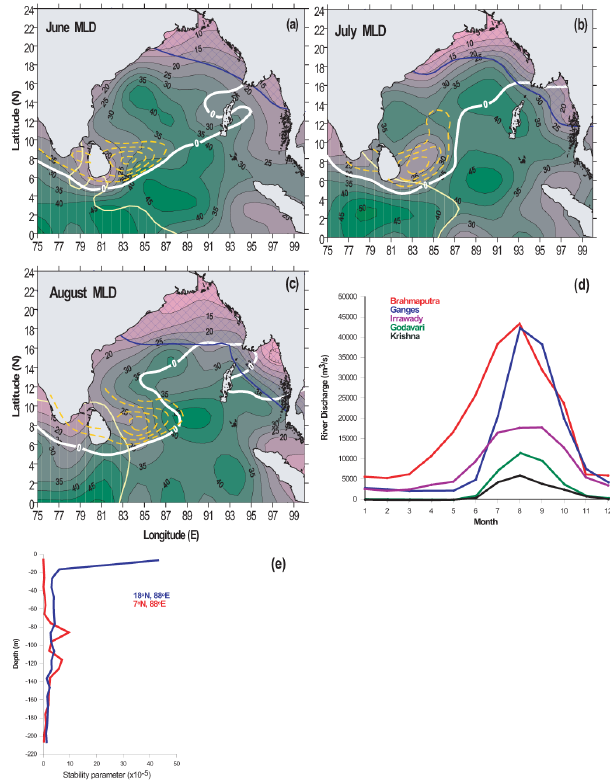
Figure 5. Monthly mean climatology of mixed layer depth (m) in the Bay of Bengal during summer in (a) June, (b) July and (c) Au- gust; (d) monthly mean river discharge climatology of the Ganges, Brahmaputra, Irrawaddy, Godavari and Krishna rivers; and (e) ver- tical profiles of the upper ocean stability parameter ( E , m − 1 ) at 18 ◦ N, 88 ◦ E (blue line) and 7 ◦ N, 88 ◦ E (red line) in the Bay of Bengal during July. In (a–c) the blue crosshatch represents the re- gion where salinity is less than 32psu, while vertical lines within the thin yellow solid line represent the region where the salinity is greater than 34.5psu. The thick broad white line indicates the zero wind stress curl and the region south of it (equatorward) have negative wind stress curl. The yellow broken contours indicate the positive wind stress curl (5 to 20 × 10 − 8 Pam − 1 ) with increasing magnitude towards the